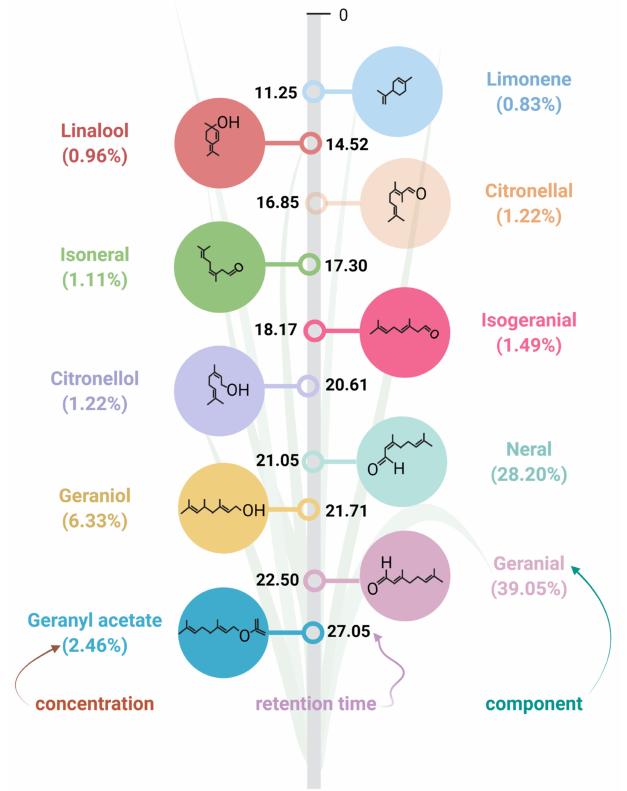
Figure 3. The abundant bioactive phytocomponents present in lemongrass essential oil. Cymbopogon flexuosus (Steud.) Wats var. Nima was grown and cultivated in Aligarh, India (27 ◦ 52 (cid:48) N, 78 ◦ 51 (cid:48) E). The fresh plant leaves were cultivated, and oil was extracted according to Guenther [19]. Further, gas chromatography-mass spectrometry (GC-MS) analysis revealed the compositional makeup of LEO. LEO components were distinguished according to their retention times (depicted, here, only from 0 to 27.05) and are mentioned here following their order of elution in the solid phase. Percentage abundance below each compound represents the percent peak area covered by the component during GC-MS analysis. Created with